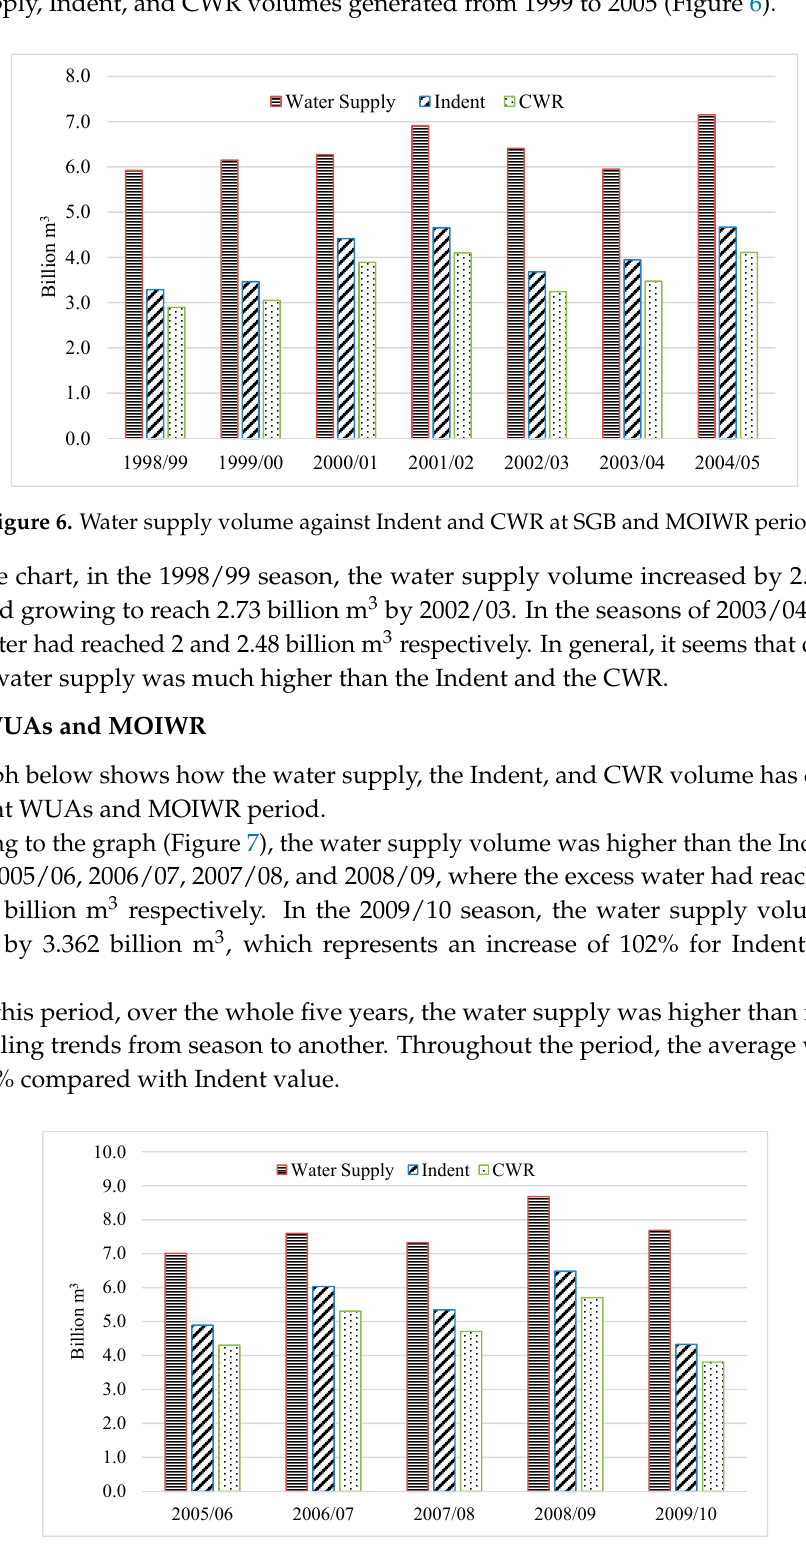
Figure 7. Water supply volume against Indent and CWR at WUAs and MOIWR period.